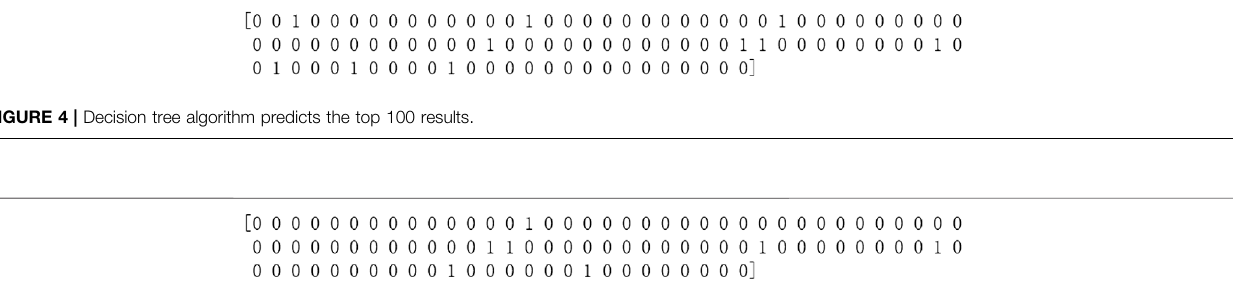
FIGURE 5 | Bayesian Algorithm predicts the top 100 results.